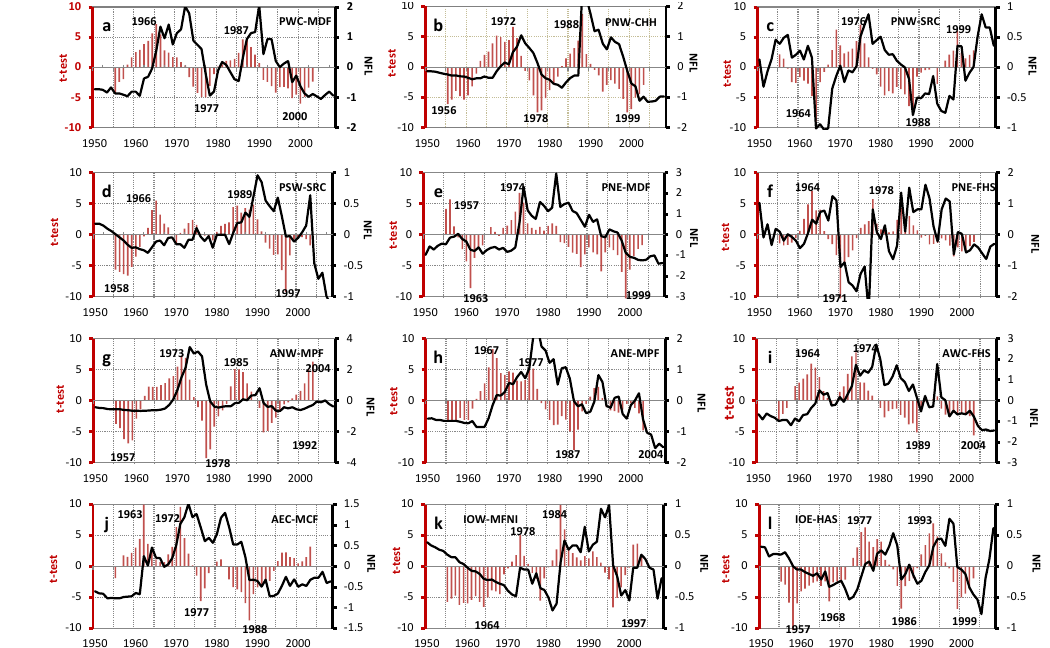
Figure 3. The detrended time series of the normalized fishery landing (NFL) with black curves over the three ocean basins (scaled on the right y axis), the 11-year running t test with red bar (scaled on the left y axis). The number indicates the year when the regime shift happened, based on passing the significance test at the 90% confidence level. Each panel in this figure is the sample selected from the total 14 sub-regions and 9 species groups listed in Table 1A. Pacific Ocean: (a) PWC-MDF; (b) PNW-CHH; (c) PNW-SRC, (d)